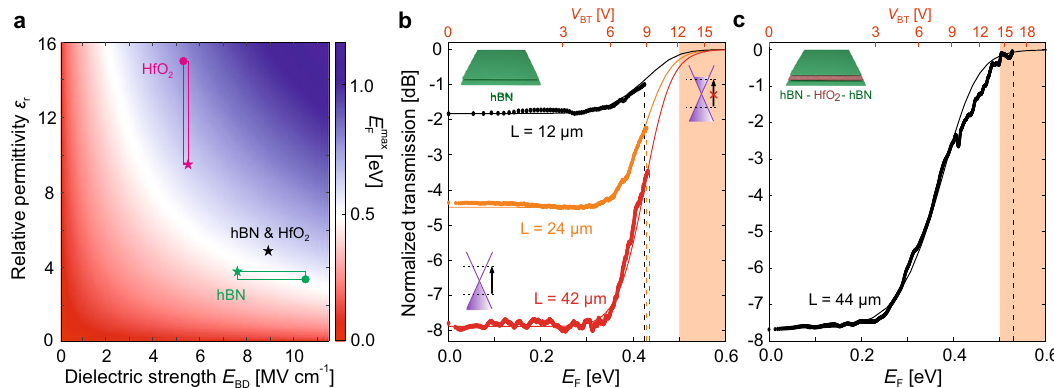
, expected at the graphene electrodes of a graphene Fig. 3 Dielectric breakdown and Pauli blocking operation. a Maximum Fermi energy, noted E max F modulator with a dielectric ’ s relative permittivity ϵ r and dielectric strength E BD . All points lying inside the blue-colored region represent a dielectric allowing 0 : 5 eV, refer to Supplementary Note 1). The red-colored region indicates otherwise ( E max 0 : 5 eV). The white band for Pauli blocking operation ( E max F > F < ¼ 0 : 5 eV. The expected E max represents the Pauli blocking boundary condition, de fi ned as E max for HfO 2 and hBN are represented by the red and green F F squares, respectively, taking the values of E BD and ϵ r from literature 28,35 – 37 (marked with dots) and our dielectric characterization (marked with stars, see ¼ 0 : 57 eV expected for the hBN – HfO – hBN modulator in Fig. 1e (see Supplementary Supplementary Notes 5 and 10). The black star represents the E max 2 F Note 10). b , c Normalized transmission as a function of E F and V BT for modulators with hBN (b) and hBN – HfO 2 – hBN (c) dielectric. The data points are measurements and the solid curves simulations (see Supplementary Notes 1 – 3 and 10). The vertical dashed lines indicate the E max achieved at the dielectric F breakdown. The orange-shaded regions show the full transparency range, i.e., Pauli blocking. The top V BT axis in panel b is for the 42 μ m-long device only (see Supplementary Note 7 for the other hBN devices). The graphene Dirac cones in panel b show the absorption and Pauli blocking processes at low and high Fermi energies,